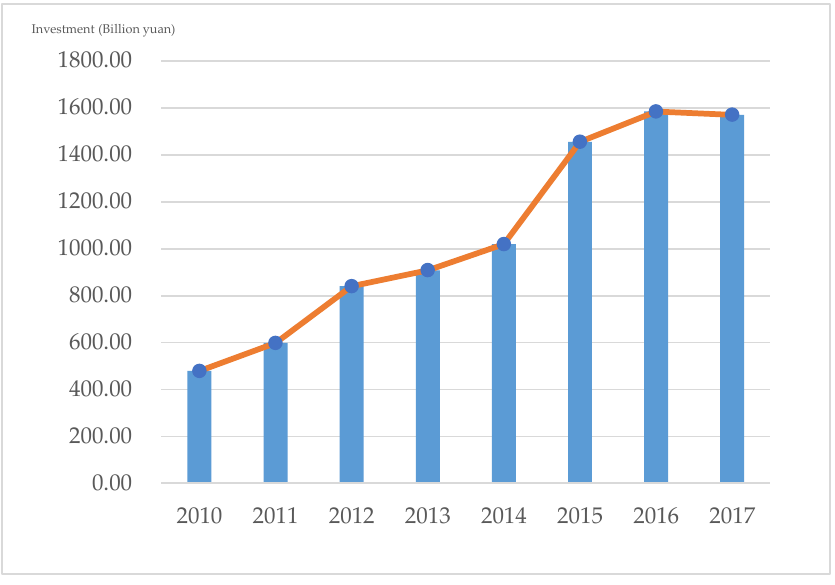
Figure 2. Amount of investment in the energy industry in Jiangsu Province, 2010 – 2017.